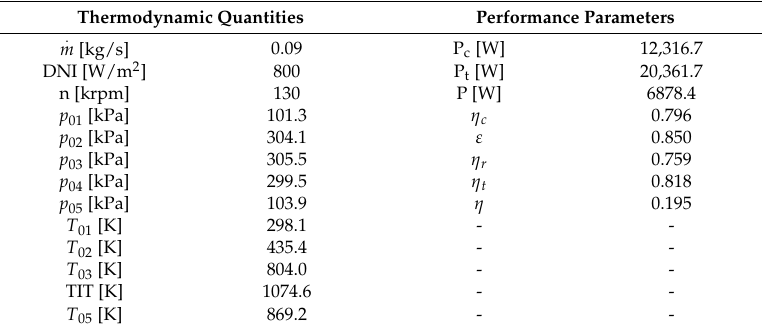
Table 3. The design parameters for the 7-kWe